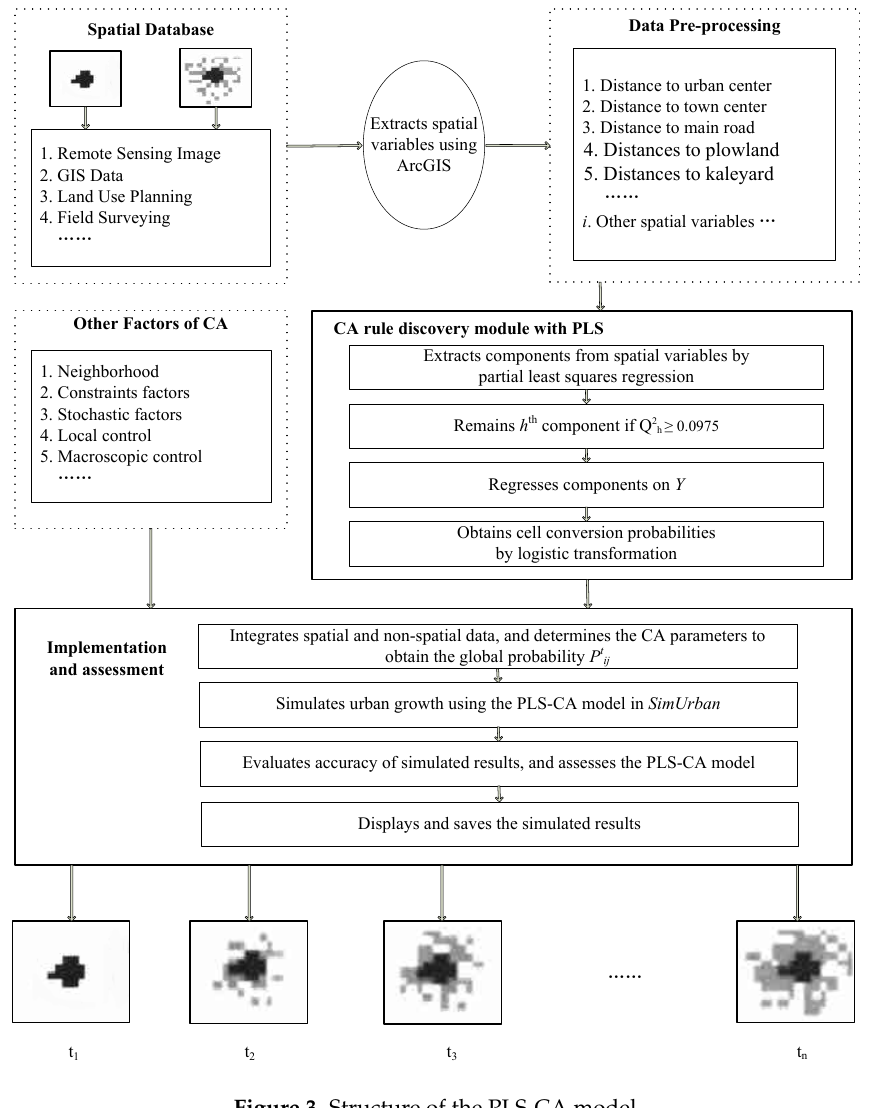
Figure 3. Structure of the PLS-CA model.